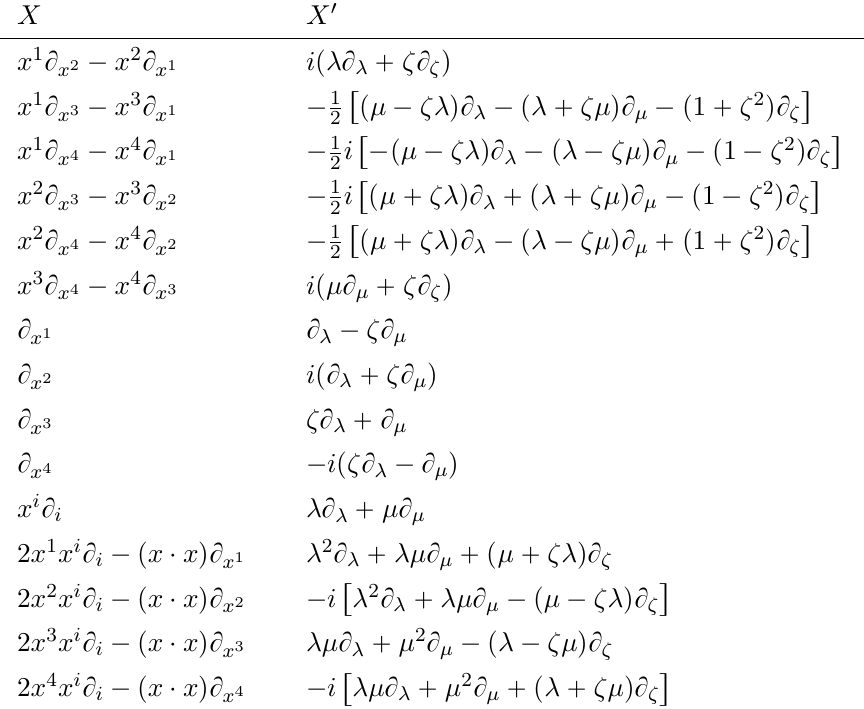
Table 1 . Conformal Killing vectors and their lifts to twistor